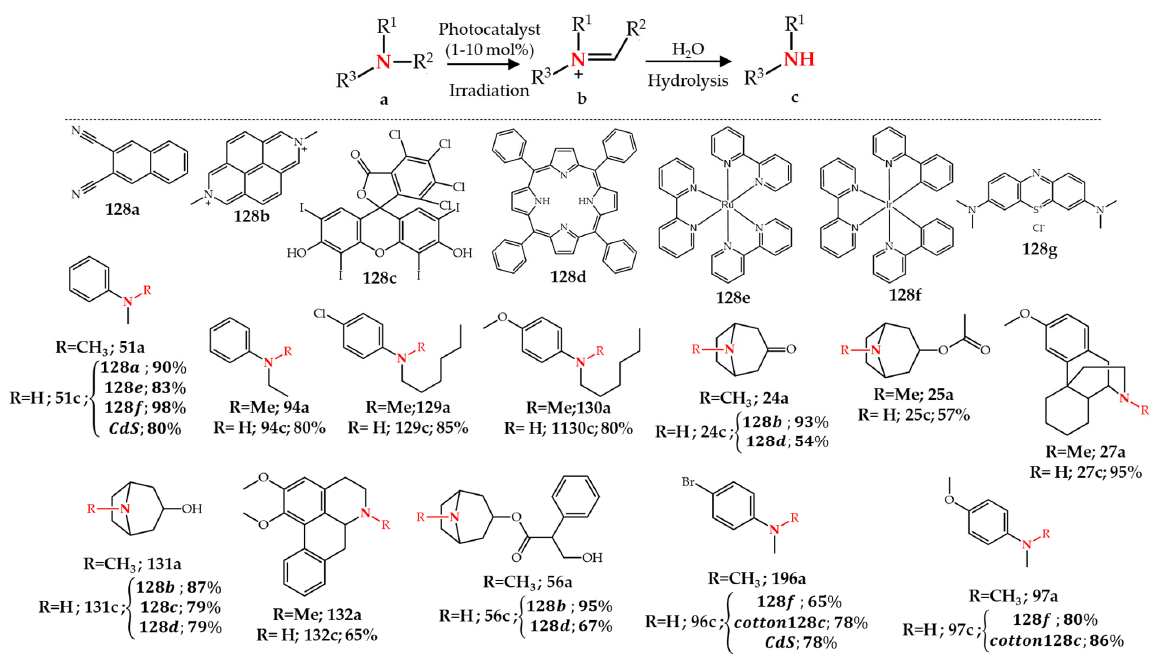
Figure 18. Photochemical N ‐ dealkylation of various tertiary amines. Metal complexes such as the ruthenium or iridium complexes 128e and 128f have also been applied as photocatalysts for the N ‐ demethylation of N,N ‐ dimethylaniline de ‐ rivatives 51a , 96a , and 97a . In this method the presence of 1,4 ‐ diazabicyclo [2.2.2]octane (DABCO) as additive increased the yield of the final product while using only 1 mol% of 128e or 128f [164] (Figure 18). An innovative technique for recycling and reuse of photo ‐ catalyst 128c was developed recently by immobilizing 128c via an ionic bond onto cotton. Cotton fibers are an abundant natural material carrying hydroxyl groups on their surface which enables facile functionalization with 128c . The cotton ‐ 128c photocatalyst was then applied for the N ‐ demethylation of N,N ‐ dimethylaniline derivatives such as 96a and 97a [165] (Figure 18). The presence of DABCO and acetic acid was necessary to perform N ‐ demethylation reaction. This photocatalyst is recyclable and reusable by removing it from the reaction solution [165]. Recently, Firoozi and Sarvari [166] designed and synthesized a heterogenous and recyclable photocatalyst, cadmium sulfide (CdS) nanoparticles, for the photochemical N ‐ demethylation of tertiary amines. This reaction also requires DABCO (10 mol%) as additive beside CdS (10 mol%). The reaction proceeds at room tem ‐ perature under air (atmospheric pressure) using sunlight or blue LED irradiation. Besides N ‐ demethylation, this method is capable of removing ethyl and butyl groups. Im ‐ portantly, they showed the reusability of the CdS photocatalyst by five times recycling and reusing it for the synthesis of 51c with negligible difference in isolated yield [166] (Figure 18). A two ‐ step acetic acid promoted photochemical N ‐ demethylation method using Rose Bengal 128c or methylene blue 128g as photocatalysts was developed for the N ‐ demeth ‐ ylation of a wide range (up to 30 examples) of N,N ‐ dimethylaminophenyl derivatives 133a – 138a . A hydroperoxide intermediate (Figure 19A, compound b ) was formed upon the photochemical oxidation of tertiary amines which in a second step was hydrolyzed in acidic methanol (3 N H 2 SO 4 ) to obtain the corresponding secondary amines. Beside the presence of DABCO, the addition of up to 25 equivalents of acetic acid increased the con ‐ version of 133a from 12% to 98%. This method was used in the gram ‐ scale synthesis of the N ‐ demethylated metabolite of mifepristone 139a in 60% yield [167] (Figure 19A).